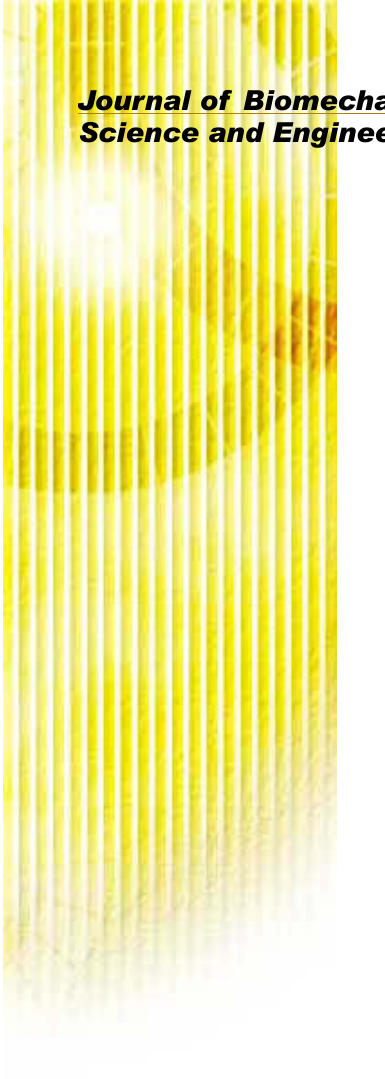
The identified intrinsic parameters were not significantly different between the two sessions and between three groups. The intrinsic model parameters were not significantly correlated with the EMG duration and peaks sum, which implies that the intrinsic parameters are rather independent of the spastic muscle responses. Table 4. Identified muscle spindle model parameters for each participant